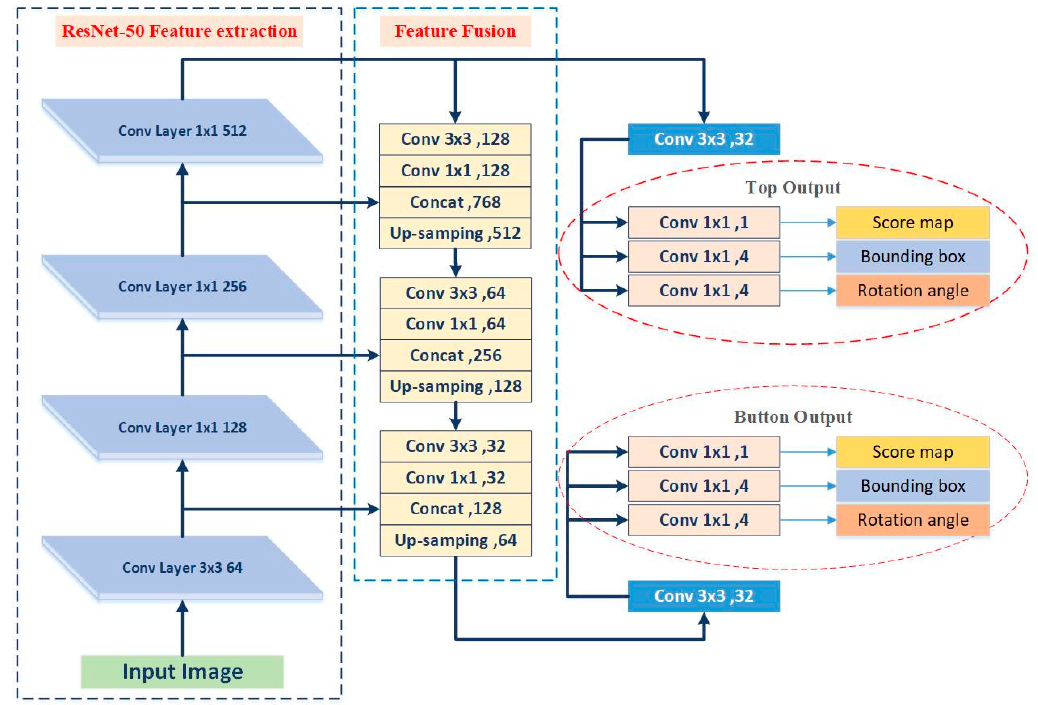
Figure 3. Architecture of our AD-FCN. AD-FCN is mainly divided into three parts: feature extraction, feature fusion, and result output. In order to avoid the problems of over-fitting and gradient explosion that may occur in the training process, the initialization of the feature extraction network was completed by using the transfer learning method and the ResNet50 [21] model for reference. In the feature fusion part, the U-Net idea was used for reference. On the basis of FCN, the high-dimensional and low-dimensional features in the convolutional network are fused to realize pixel-level classification of images and improve detection accuracy. In the output part, the confidence score map of one channel, the rectangular frame boundary information map of four channels, and the object rotation angle map of one channel are obtained through three 1 × 1 convolution layers